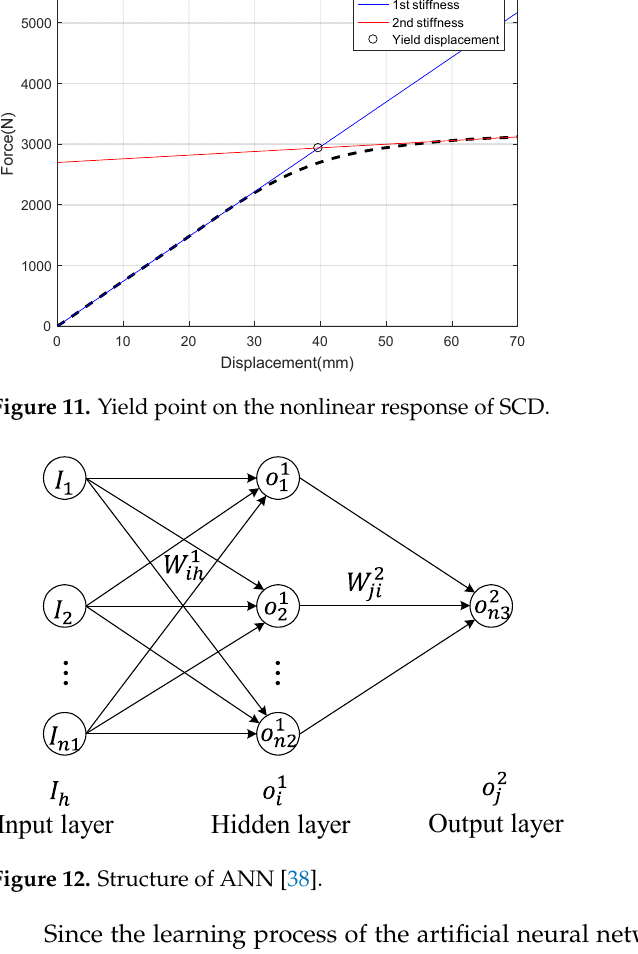
Figure 10. Flow chart for estimating the elasto-plastic response of the SCD.